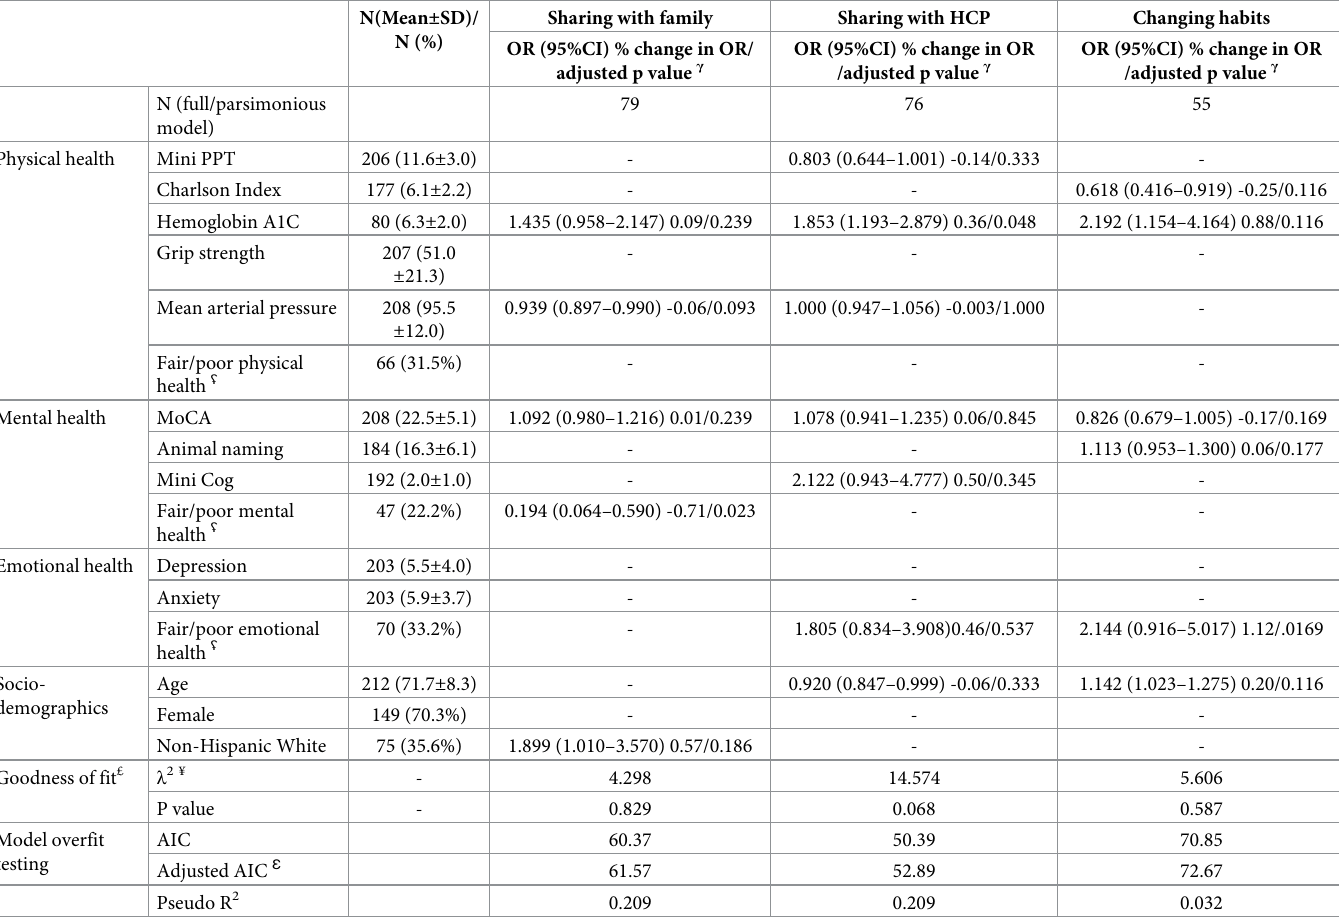
Table 2. Correlates of sharing screening results with family and HCP and changing